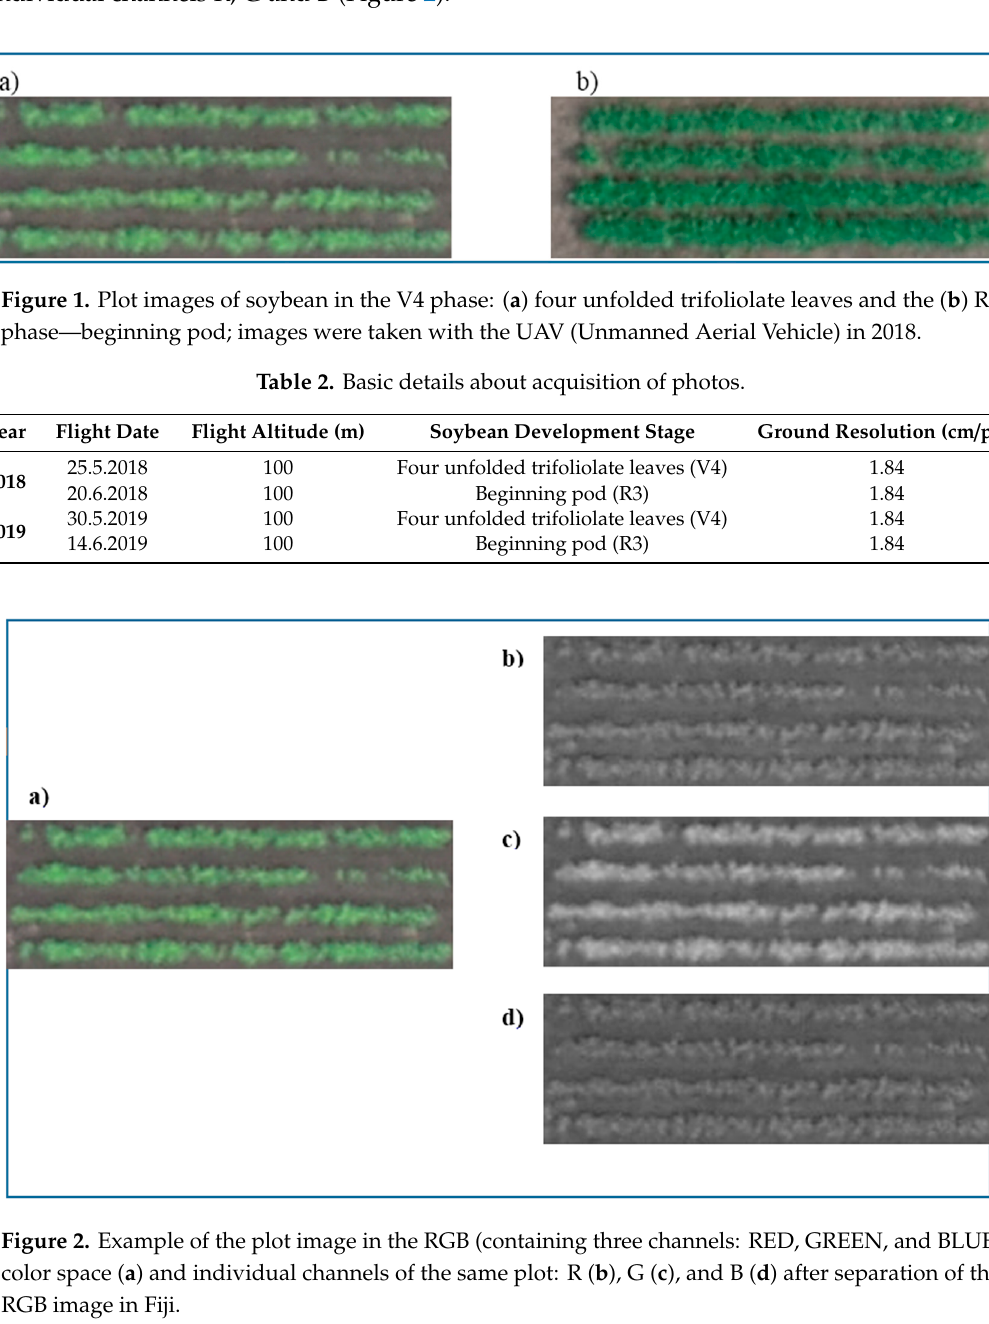
Figure 2. Example of the plot image in the RGB (containing three channels: RED, GREEN, and BLUE) color space ( a ) and individual channels of the same plot: R ( b ), G ( c ), and B ( d ) after separation of the RGB image in Fiji.